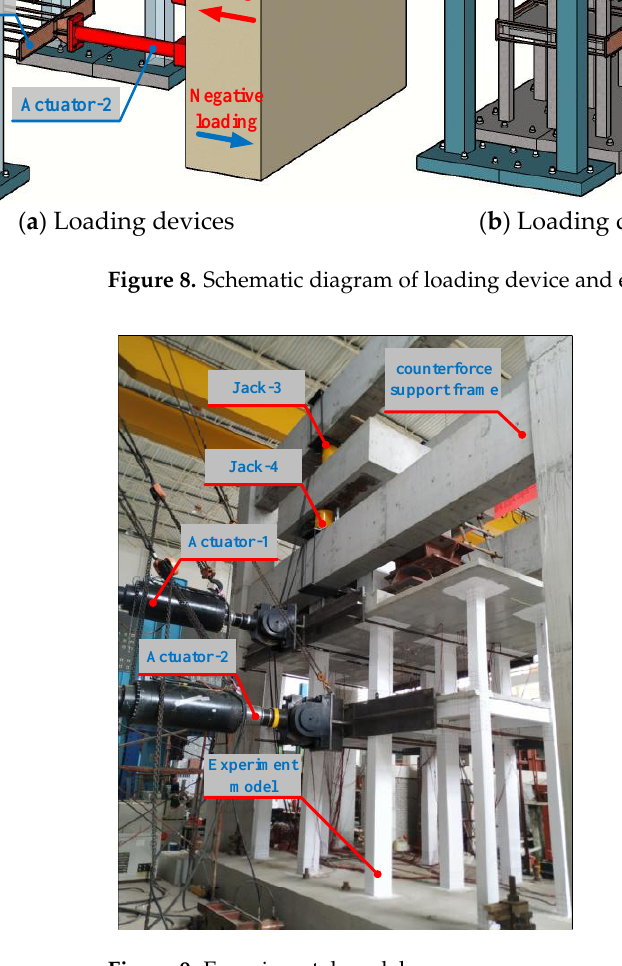
RCC Figure 11. Frame column strain layout plan.